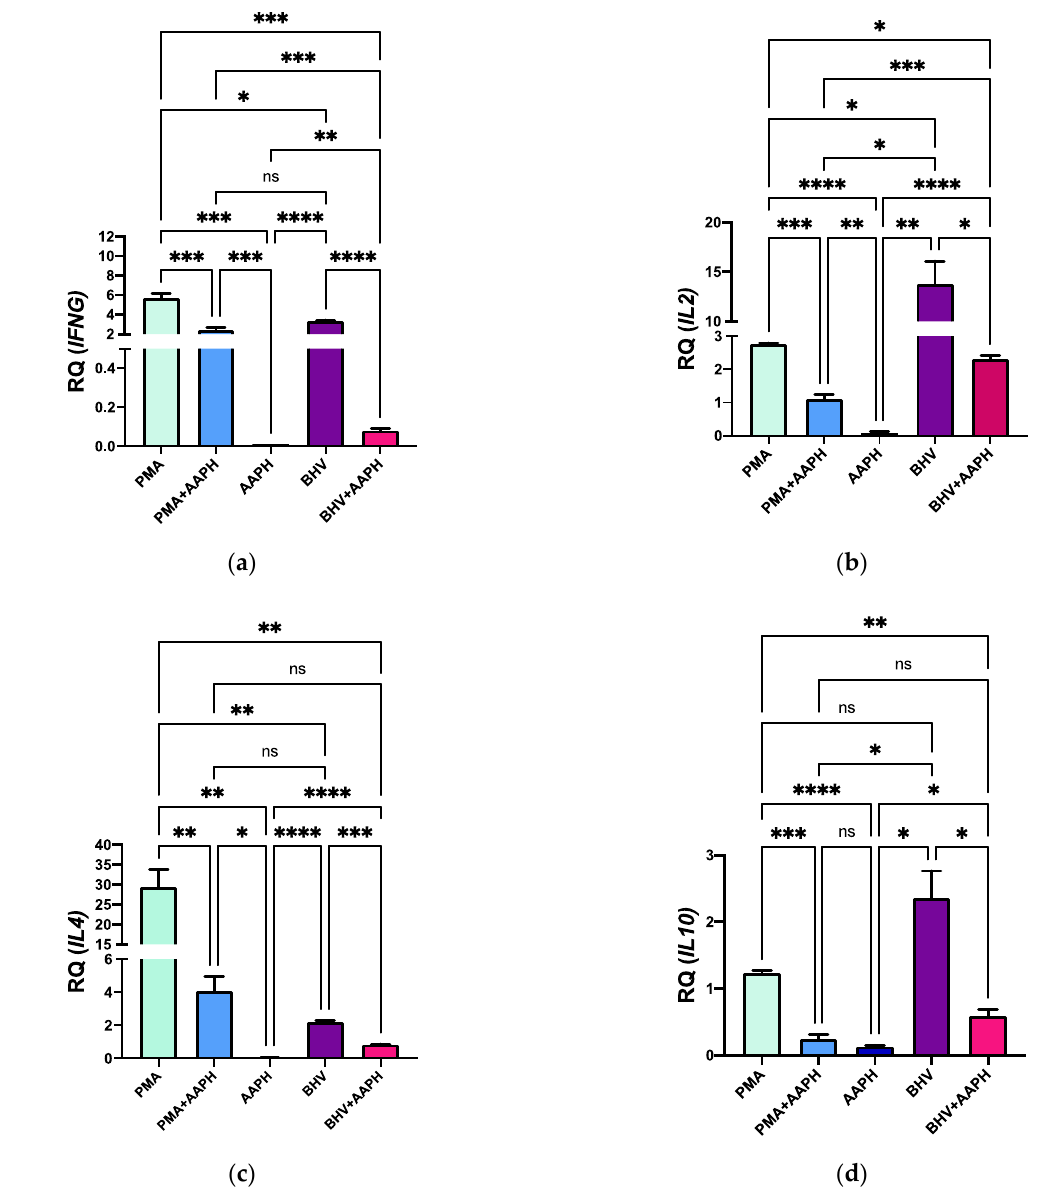
Figure 9. Relative expression of the genes ( a ) Interferon Gamma ( IFNG ), ( b ) Interleukin 2 ( IL2 ), ( c ) Interleukin 4 ( IL4 ), and ( d ) Interleukin 10 ( IL10 ) in peripheral mononuclear blood cells (PBMCs) of newborn calves. Results are normalized to the gene expression of the negative control (CON). PMA = PBMCs treated with 10 ng/mL phorbol 12-myristate 13-acetate (PMA) and 1 μ g/mL ionomycin; PMA + AAPH = PBMCs treated with 10 ng/mL PMA, 1 μ g/mL ionomycin, and 3 mM of 2,2 ′ -Azobis(2-amidinopropane) dihydrochloride (AAPH); AAPH = PBMCs treated with 3 mM AAPH; BHV = PBMCs treated 8 × 10 4 TCID 50 Bovine Herpesvirus 1 per 1 × 10 6 PBMCs; BHV + AAPH = PBMCs treated 8 × 10 4 TCID 50 Bovine Herpesvirus 1 per 1 × 10 6 PBMCs and 3 mM AAPH. Results are expressed as estimated means ± SEM of relative quantity (RQ). * p < 0.05, ** p < 0.01, *** p < 0.001, **** p < 0.0001, ns: p > 0.05.